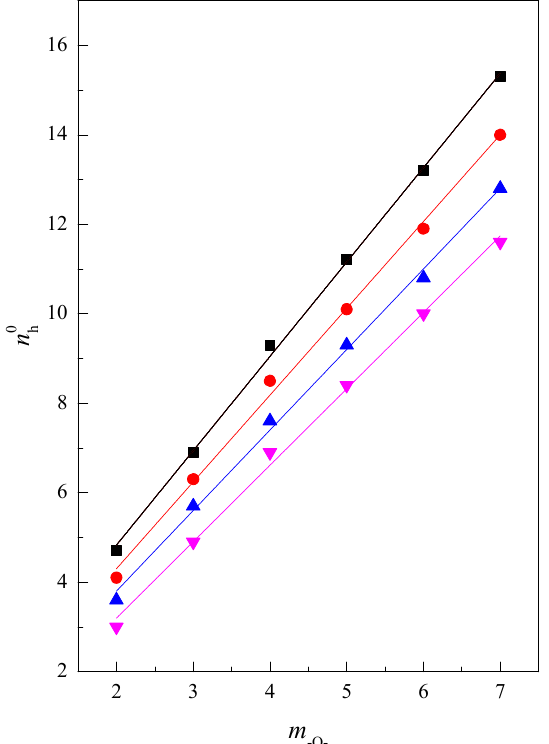
Figure 9. The hydration number ( n 0 ) as a function of number of oxygen atoms ( m –O– ) in the glyme h molecule at temperatures of ■ 293.15 K, ● 298.15 K, ▲ 303.15 K, ▼ 308.15 K.